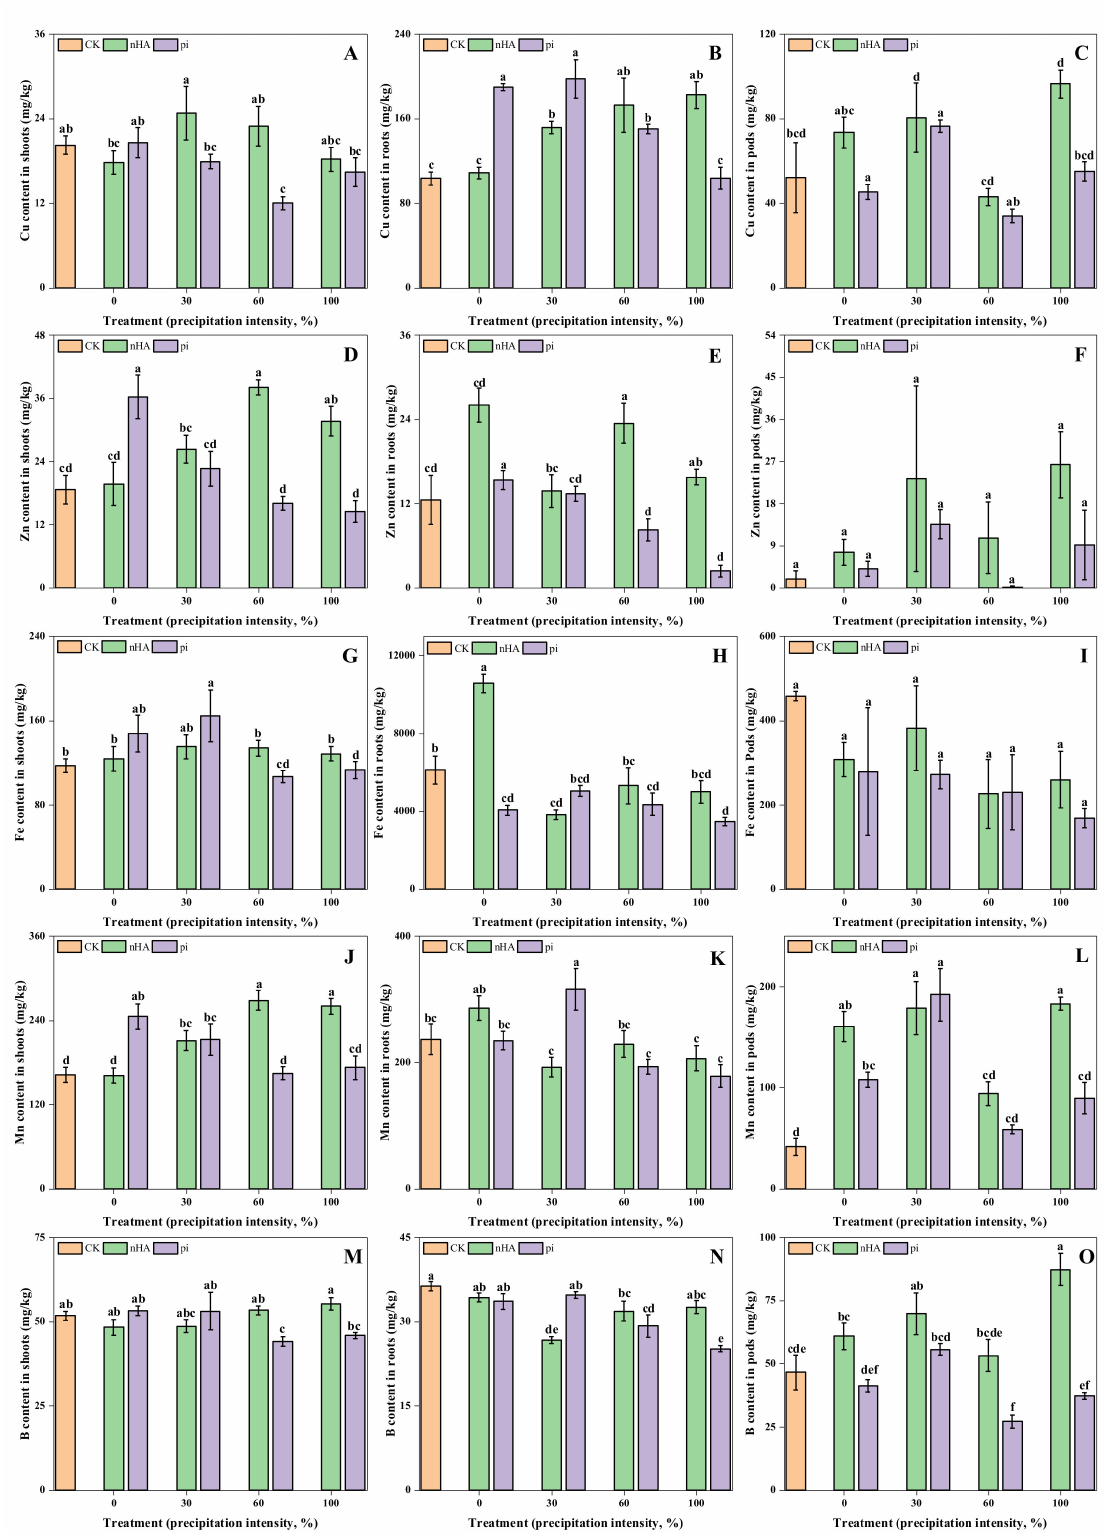
Figure 6. The content of Cu, Zn, Fe, Mn, and B in soybean shoots ( A , D , G , J , M , respectively), roots ( B , E , H , K , N , respectively), and pods ( C , F , I , L , O , respectively) treated with nHA or pi (under the simulated precipitation scenario). Error bars correspond to standard errors of the means. Values of each nutrient content in shoots, roots, and pods that are followed by different letters are significantly different at p <